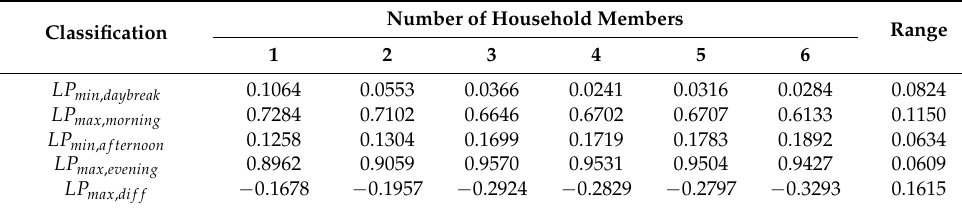
Table 3. Average feature value and range by number of household